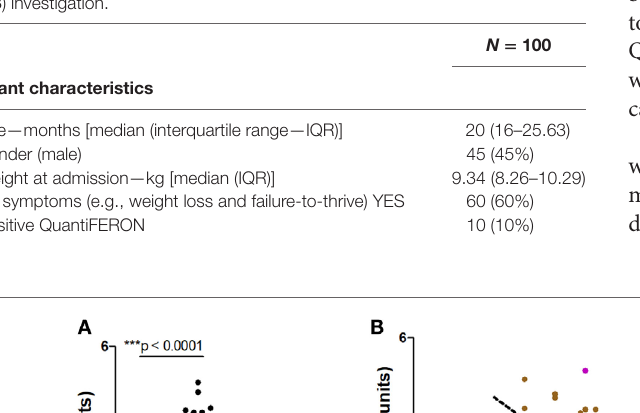
TaBle 1 | Infant sociodemographic and clinical characteristics at tuberculosis (TB) investigation.